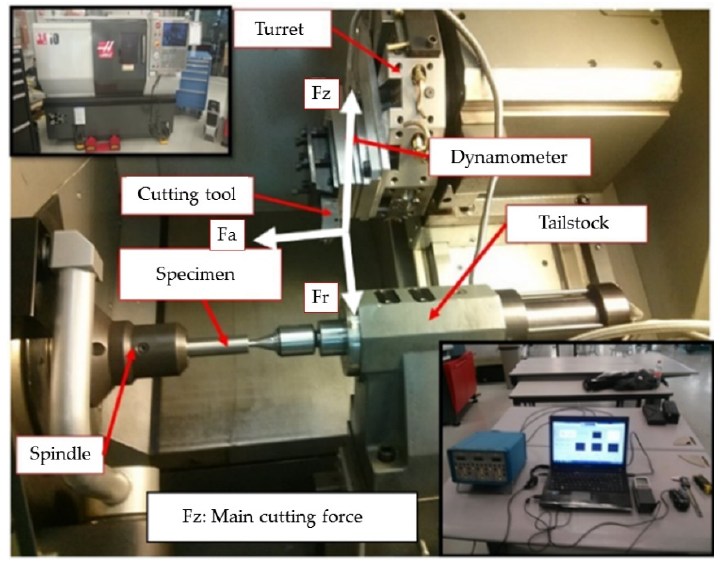
Figure 2. CNC machine tool used to perform wear tests on the cutting tools. CNC: Computer Nu- merical Control. Fz: main cutting force. Fa: axial cutting force. Fr: radial cutting force.